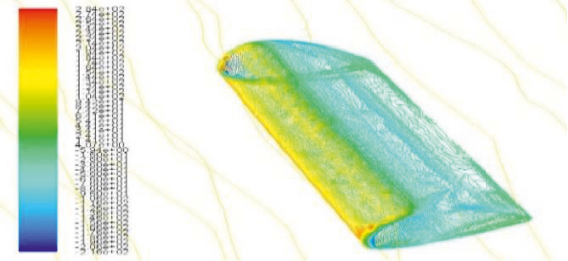
Figure 6: Total pressure at 10 ° AOA.